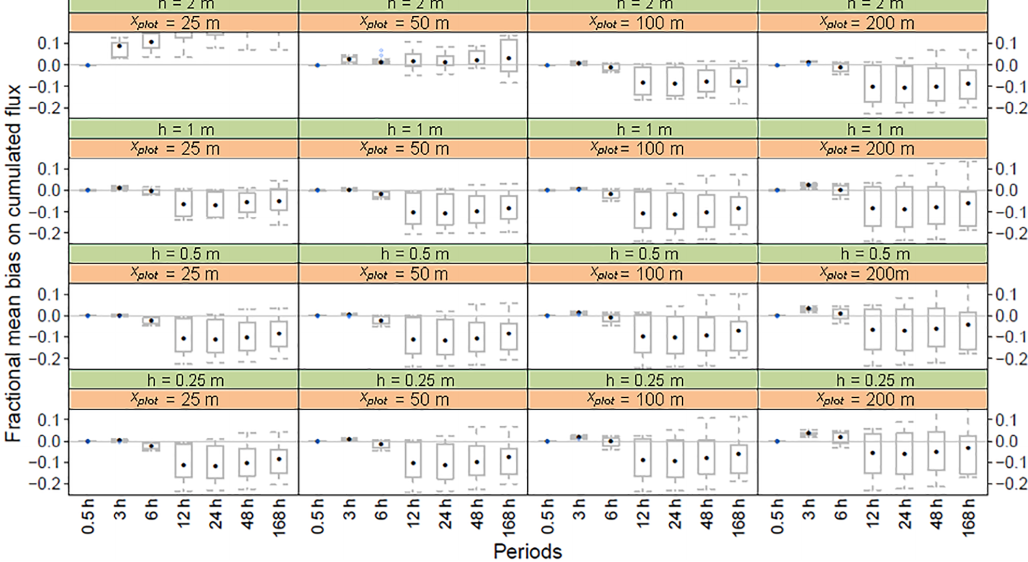
Figure 6. Fractional bias of inferred cumulated ammonia emissions for a single squared field with a lateral dimension of ( x plot ) 25, 50, 100 or 200m and sensor heights ( h ) 0.25, 0.5, 1 and 2m, as a function of sensor integrating periods. The points show the median, the boxes the interquartile, and the whiskers the maximum and minimum over the 13 application